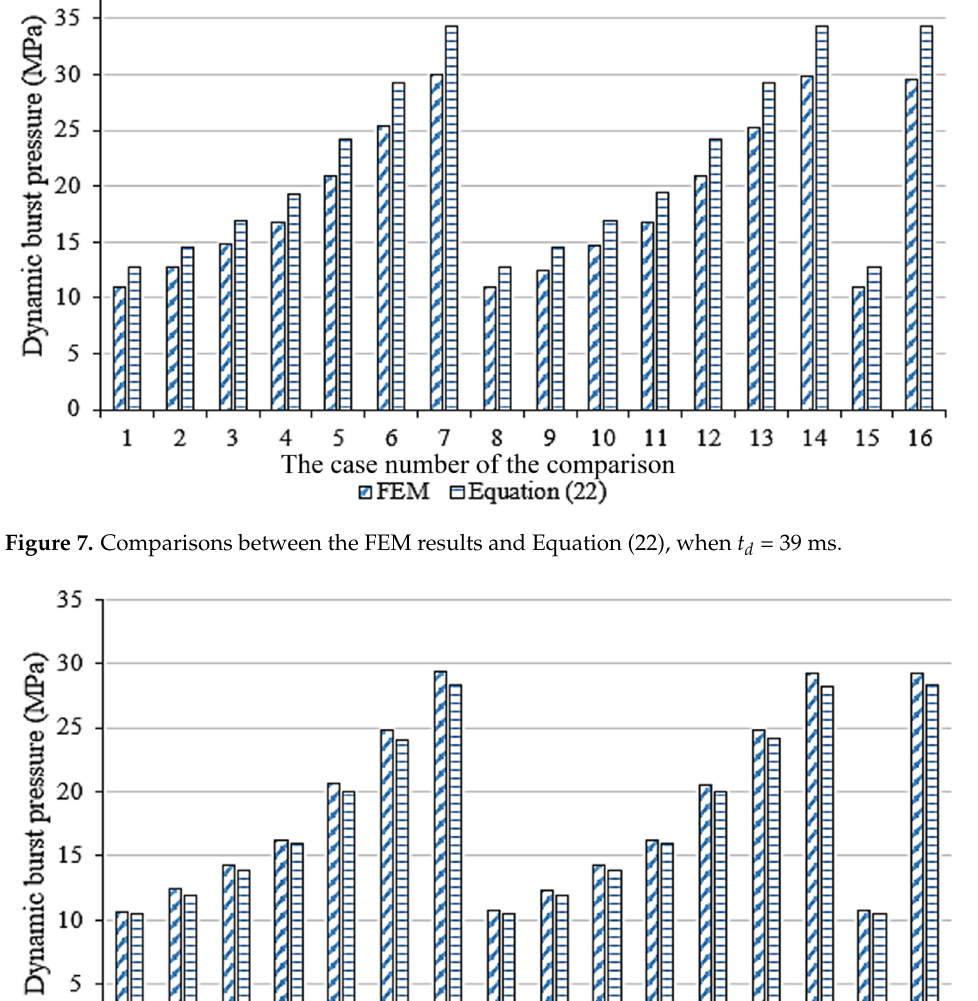
Figure 6. Comparisons between the FEM results and Equation (22), when t d = 3.9 ms.